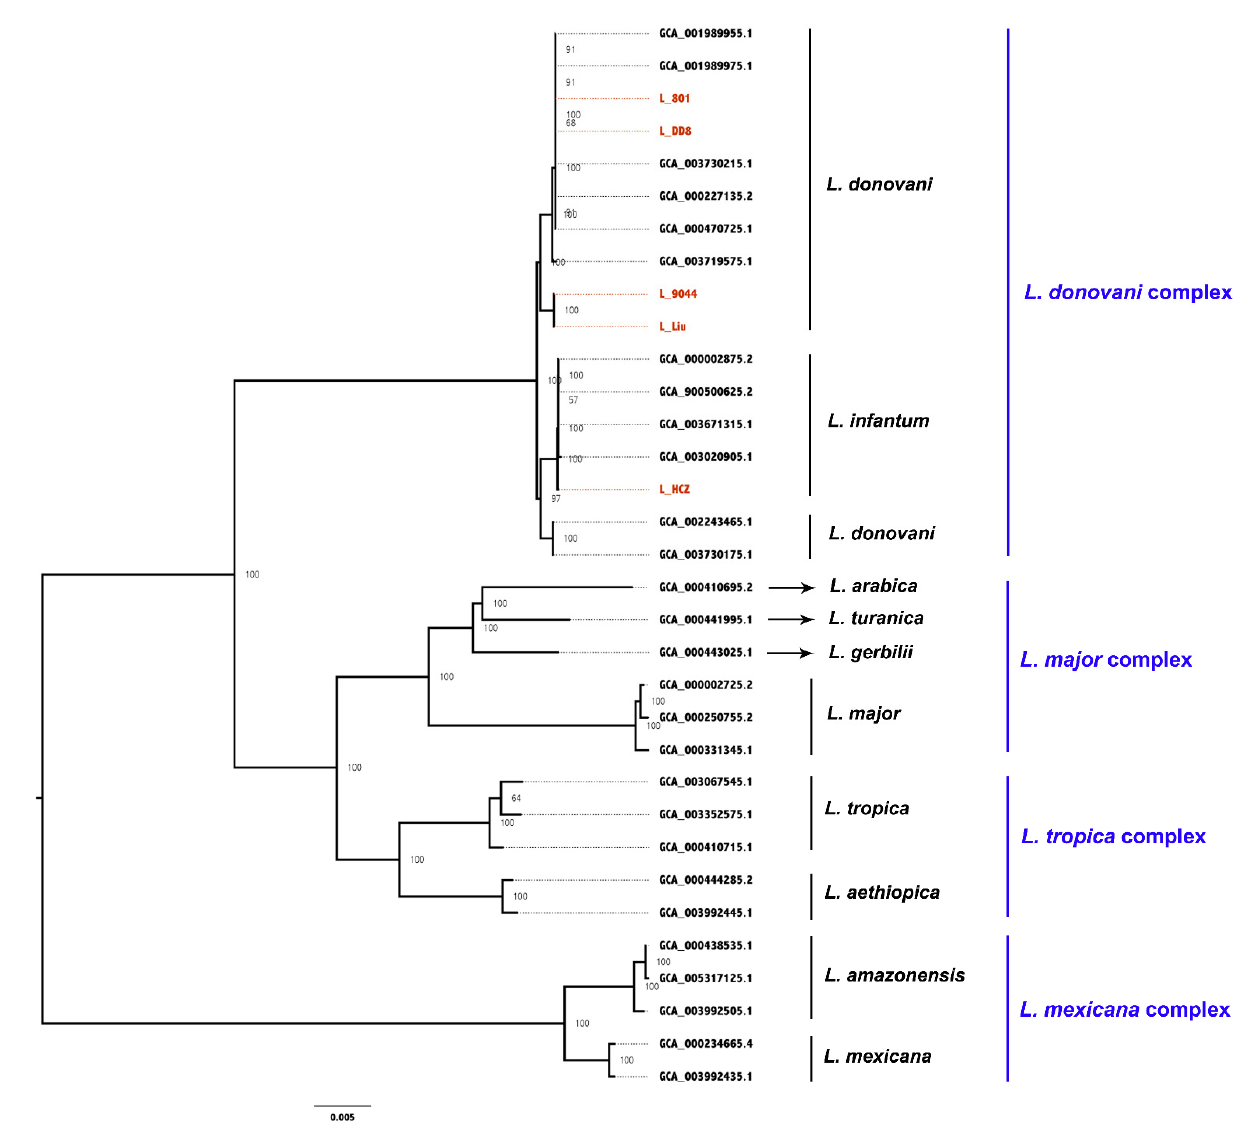
Figure 6. The core-genome based maximum-likelihood phylogeny of the 33 Leishmania strains. Node label, bootstrap values. Tip label, GenBank accession or sample name of the 33 strains. The five strains sequenced in the current study are highlighted in red, L .: Leishmaina .